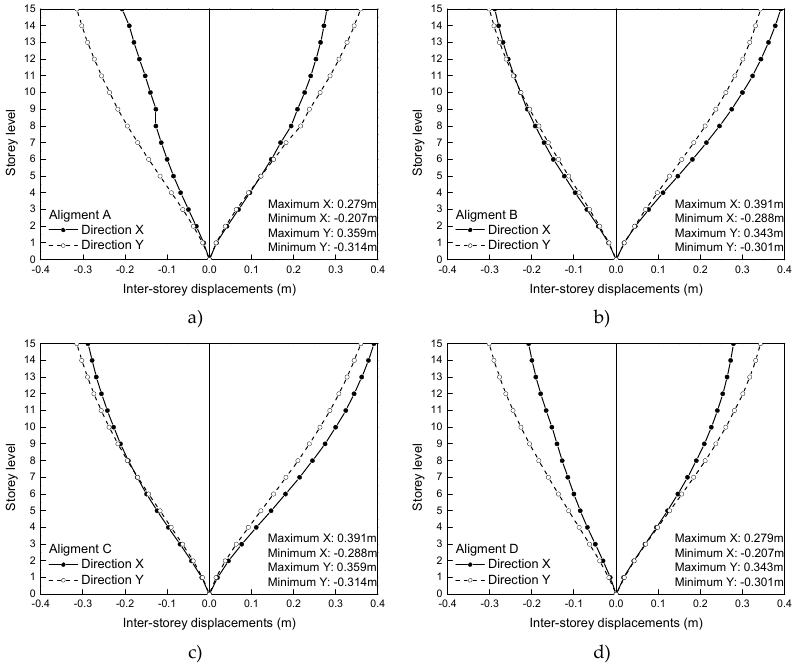
Figure 15. Linear elastic dynamic analysis result: maximum inter-storey displacement of Model 3 ( a ) alignment A; ( b ) alignment B; ( c ) alignment C and; ( d ) alignment D.